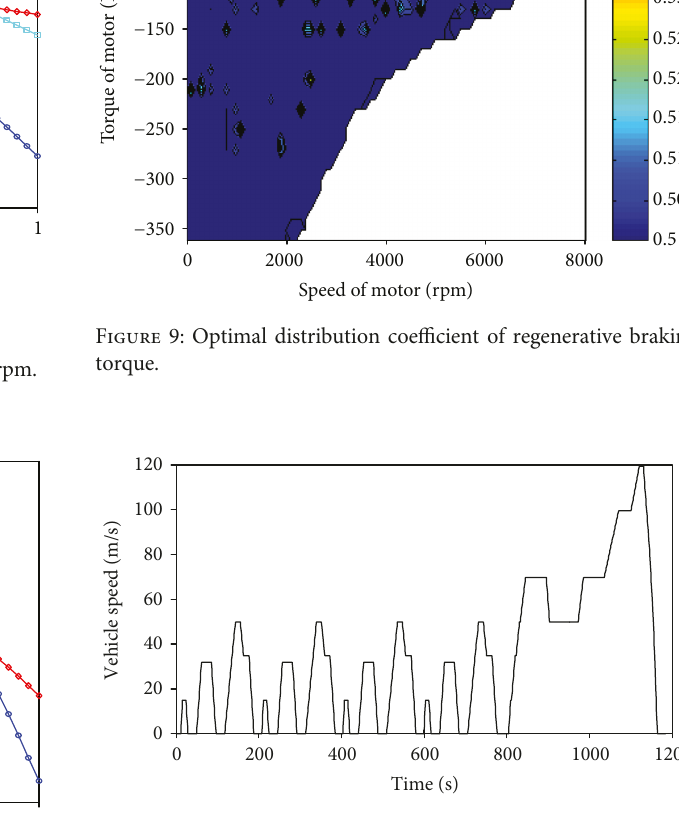
Figure 10: Speed diagram of NEDC condition based on data